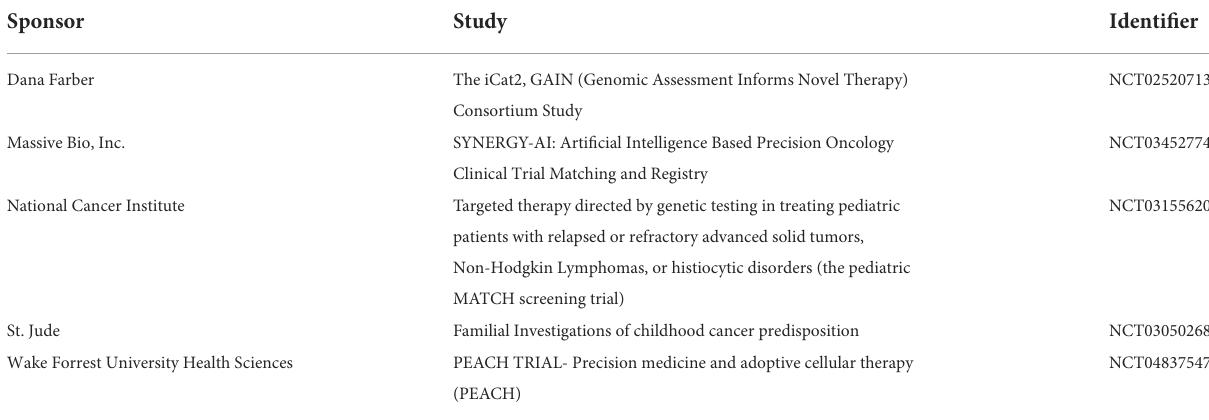
TABLE 6 Precision medicine matches enrolling pediatric patients with germline cancer mutations in the United States.